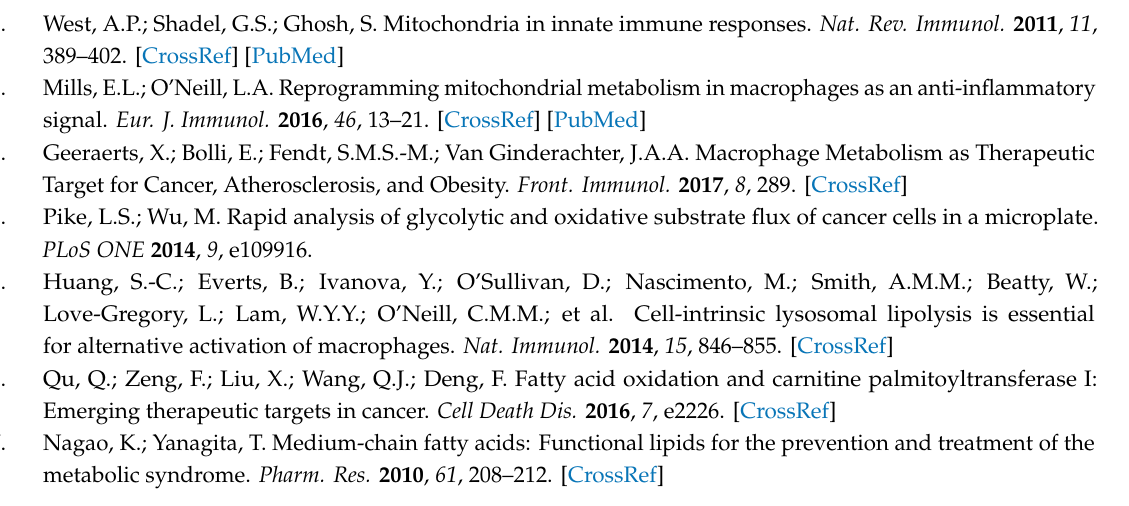
Figure S1: Mouse body weight, Figure S2: E ff ects of MCT on transcription of pro-inflammatory enzymes in RAW 264.7